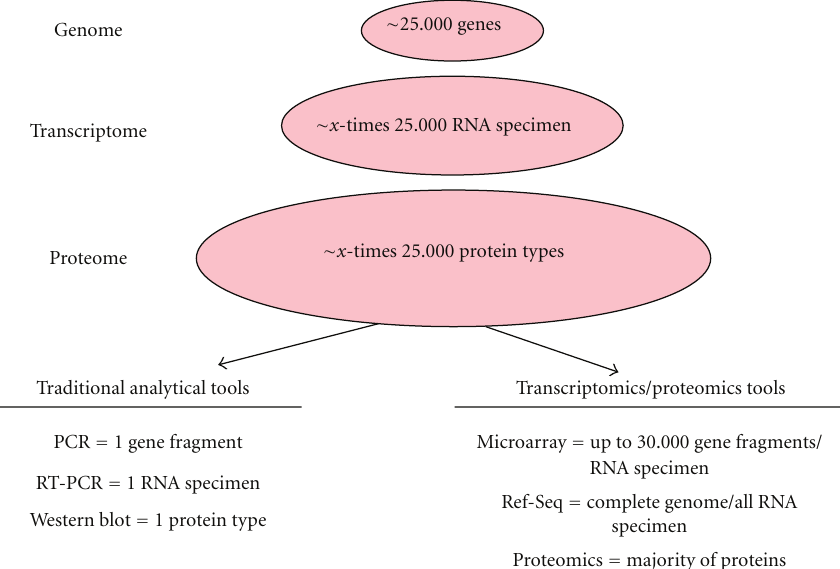
Figure 1: Traditional analytical tools for quantification of DNA, RNA, or proteins are restricted to the sequential analysisof one biomolecule specimen at a time. Research based on these tools is therefore strictly hypothesis driven. In contrast, transcriptomics tools permit the parallel quantification of thousands of biomolecules and therefore allowing for explorative, non-hypothesis-driven